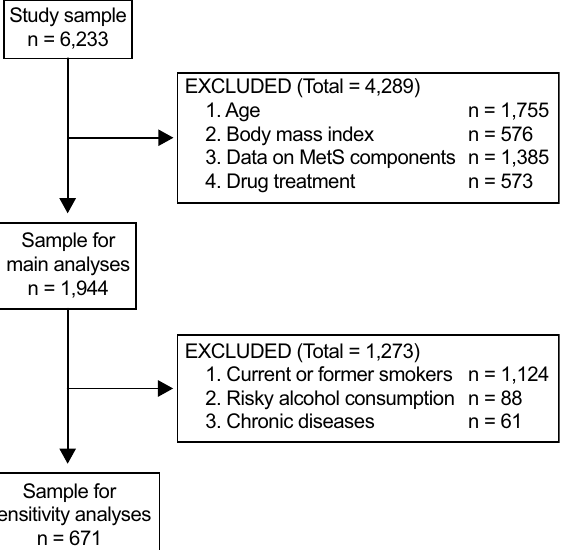
Figure 1. Flow diagram for the selection of